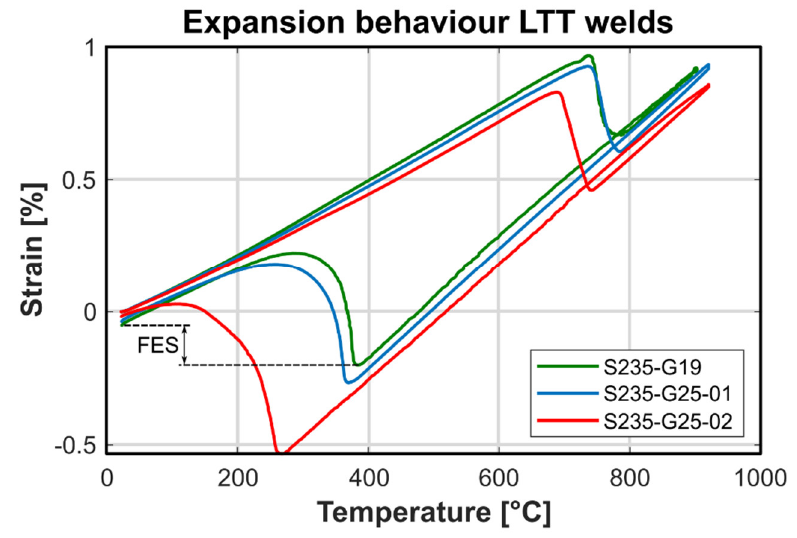
Figure 7. Dilatometry measurements of the LTT samples showing increased martensitic expansion with reduced M s temperature.